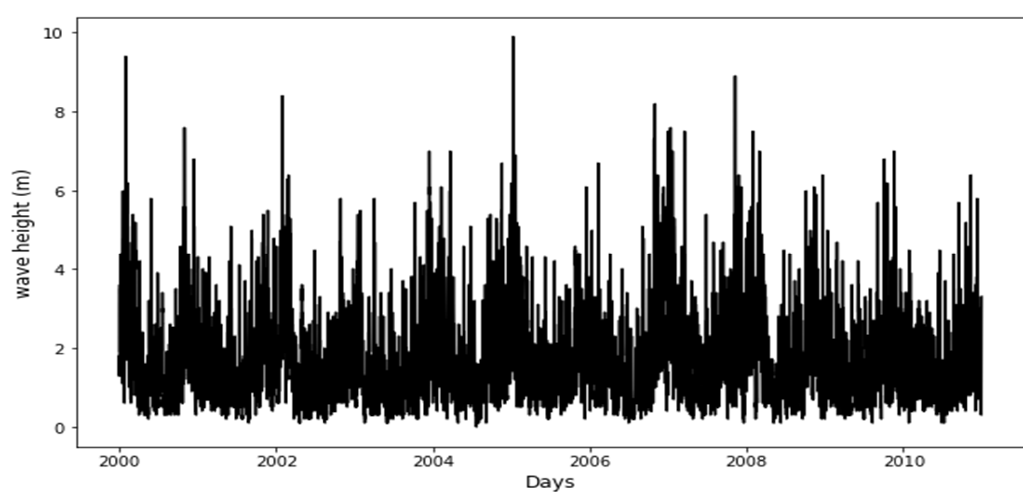
Figure 4. Raw measured wave height.